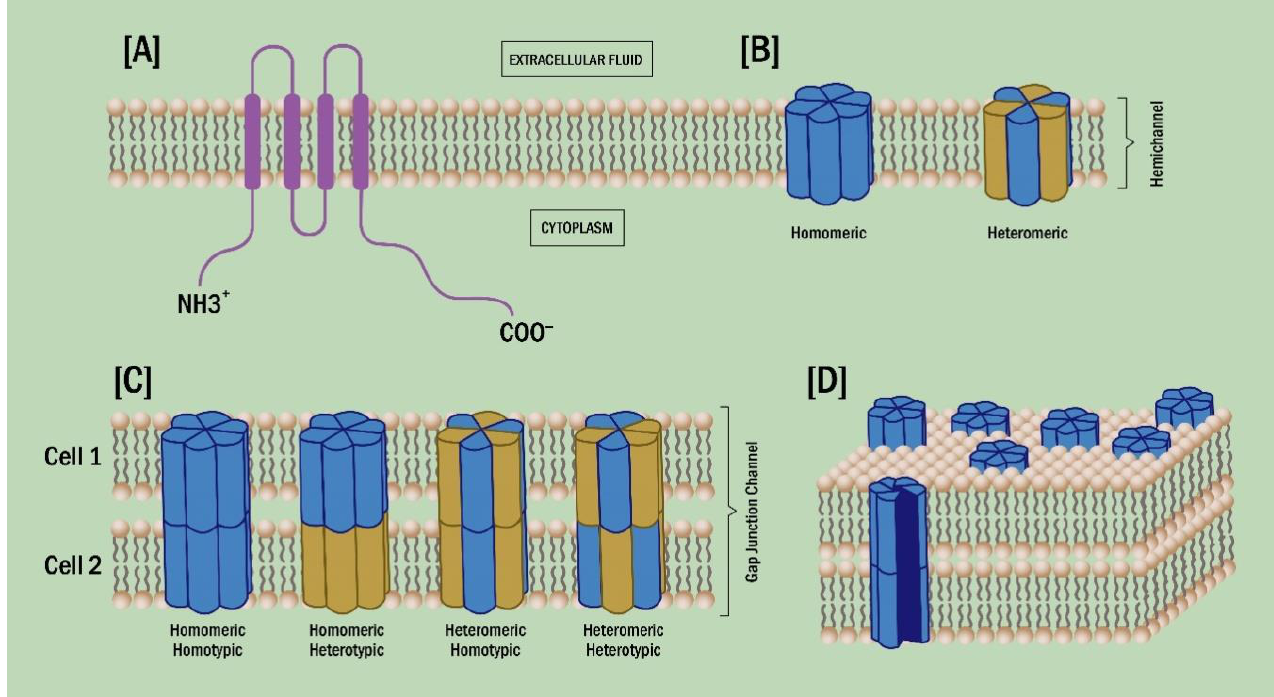
Figure 2. Connexins, hemichannels, and gap junction channels. ( A ) Connexins are membrane proteins with four transmembrane domains connected by two extracellular and one intracellular loops. Both amino- and carboxyl-termini of the protein are oriented towards the cytosolic domain of the cell. In mammals, between 19 and 21 different types of connexin genes have been reported. ( B ) The oligomerization of six connexins forms a hexamer named connexons or hemichannels (HCs). HCs can be homomeric or heteromeric if they are formed by the same or different connexin isoform, respectively. ( C ) HC interacting with opposing HC from neighboring cells can dock to form different types of gap junction channels (GJCs). ( D ) GJC can cluster to form a gap junction plaque.